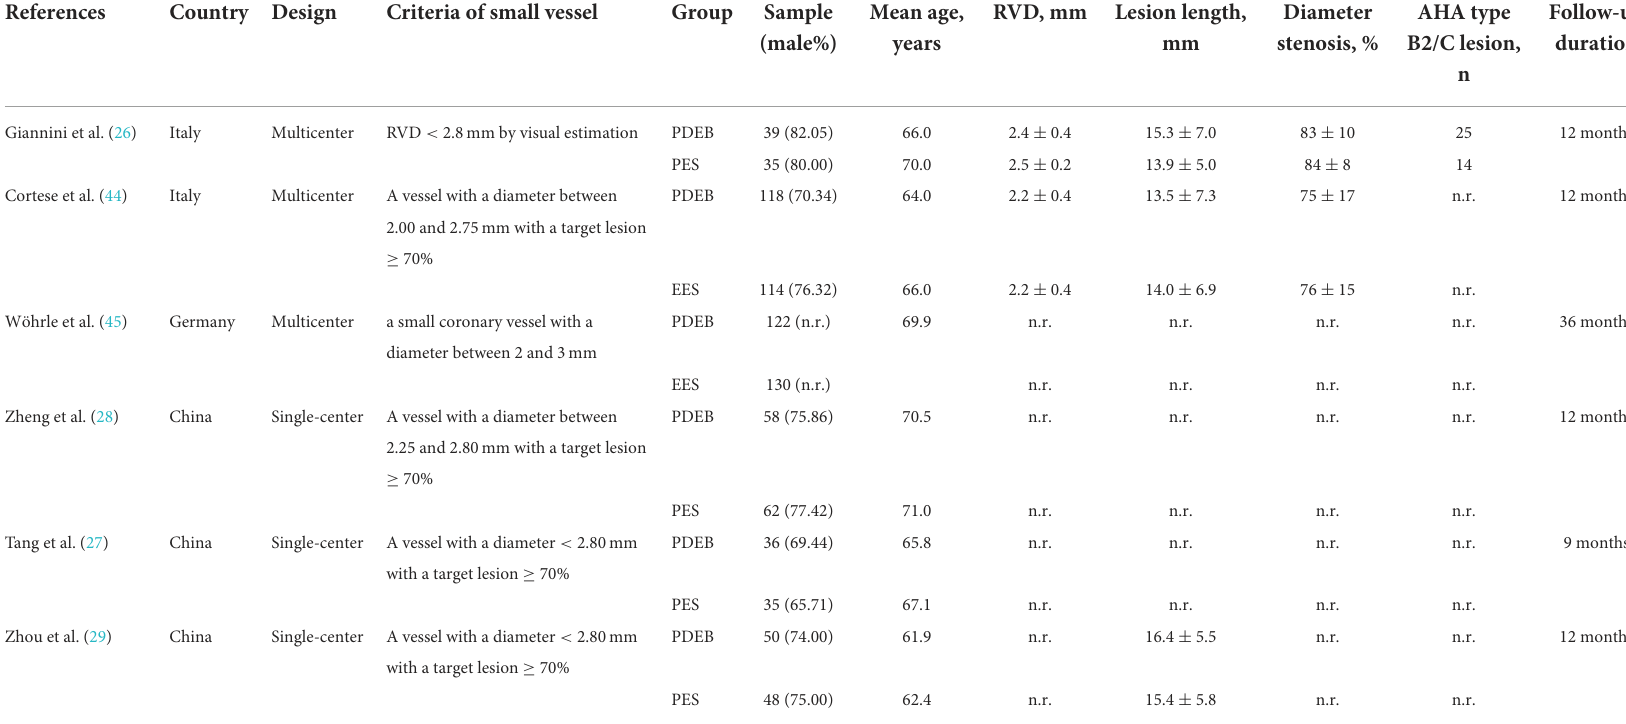
TABLE 1 Baseline information of 6 studies included in this